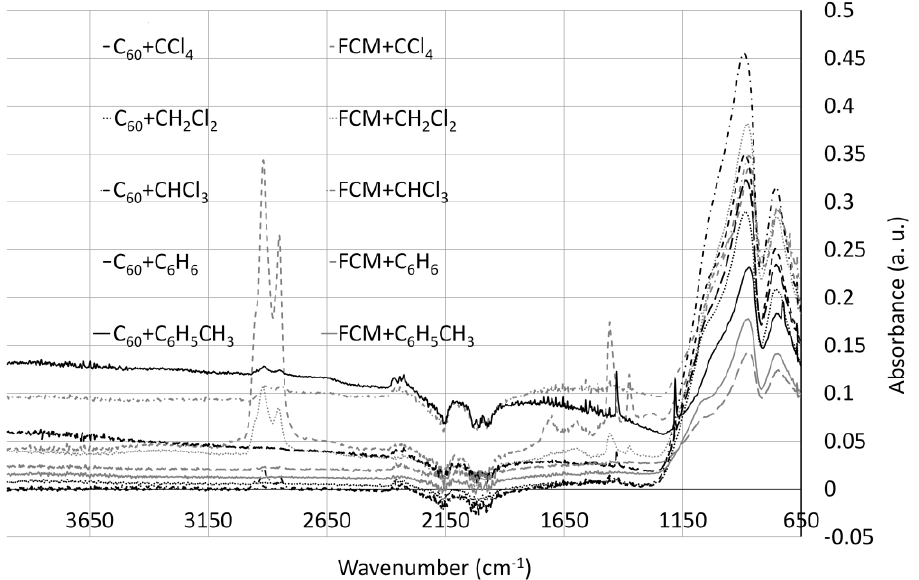
Fig. 2. IR absorption spectra of FCM films (gray lines) and C 60 (black) on glass substrates using aromatic and non-aromatic solvents (solution volume - 0.15